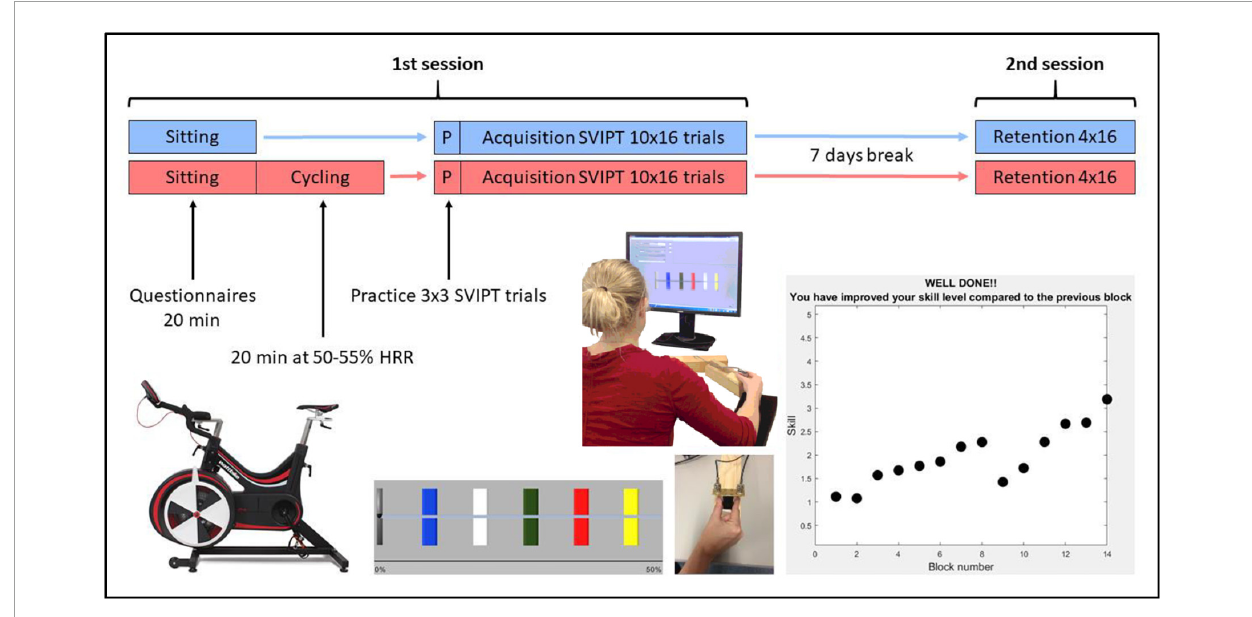
FIGURE1 Summary of the study protocol with the exercise group in red and the control group in blue. SVIPT, sequential visual isometric pinch task; HRR, heart rate reserve.